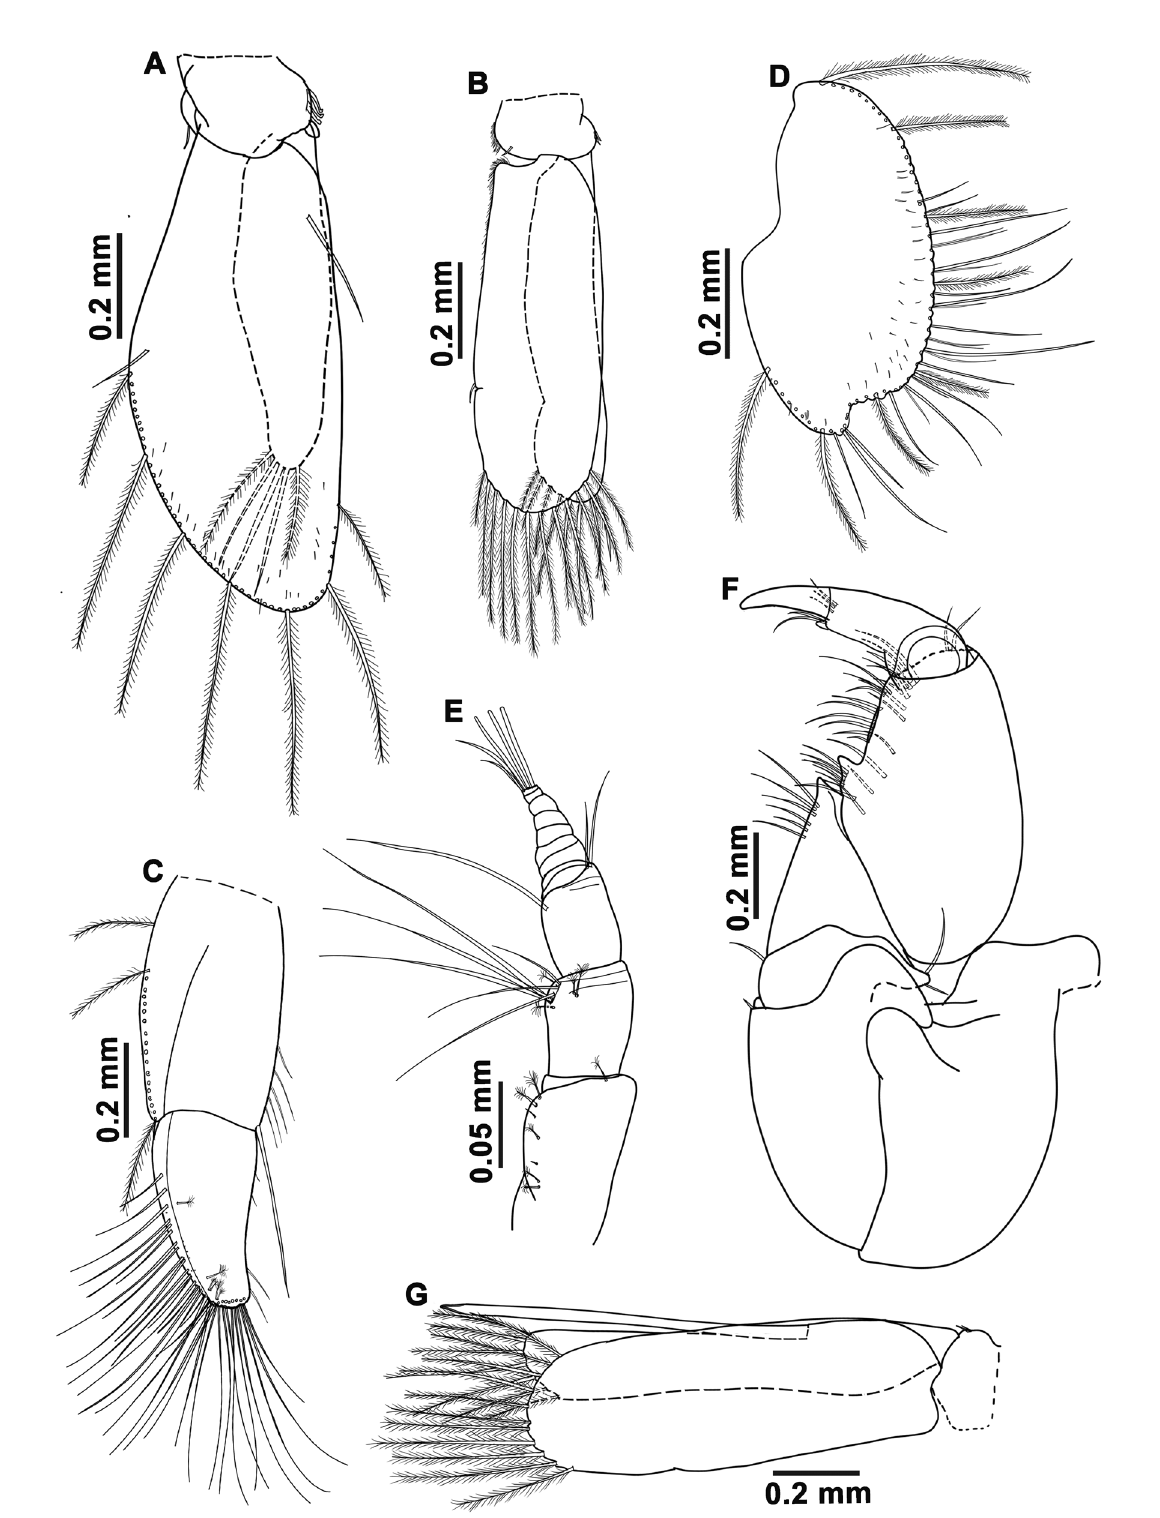
Fig. 16. Skuphonura oaxaquensis sp. nov. A–D . Holotype, ♀, 7.9 mm, Oaxaca, Puerto Ángel, Estacahuite Beach (UMAR-PERA 548). A . Pleopod 1. B . Pleopod 2. C . Uropodal endopod. D . Uropodal exopod. E–G . Paratype, ♂, 7.3 mm (UMAR-PERA 549). E . Antennule. F . Pereopod 1. G . Pleopod